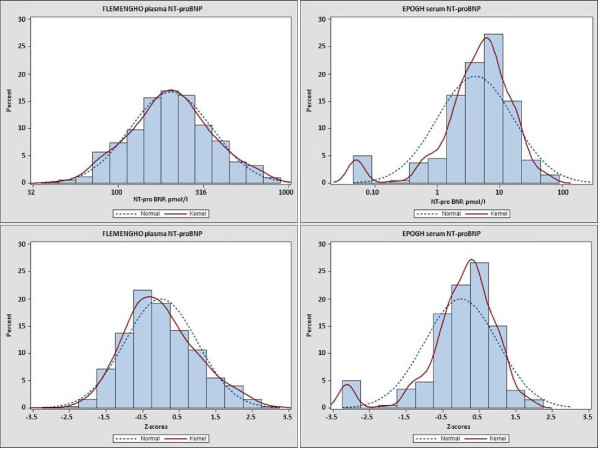
The histograms of the NT-proBNP levels (A, C) and the corresponding z-scores (B, D) by the FLEMENGHO and EPOGH cohort.